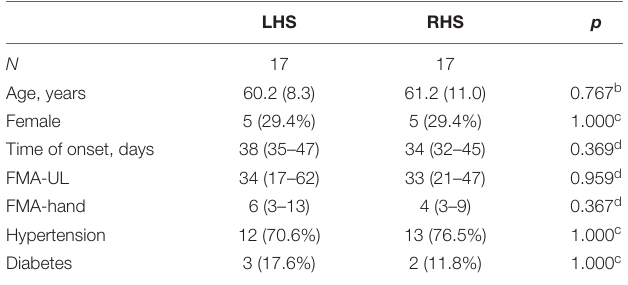
TABLE 1 | Baseline characteristics of stroke patients a